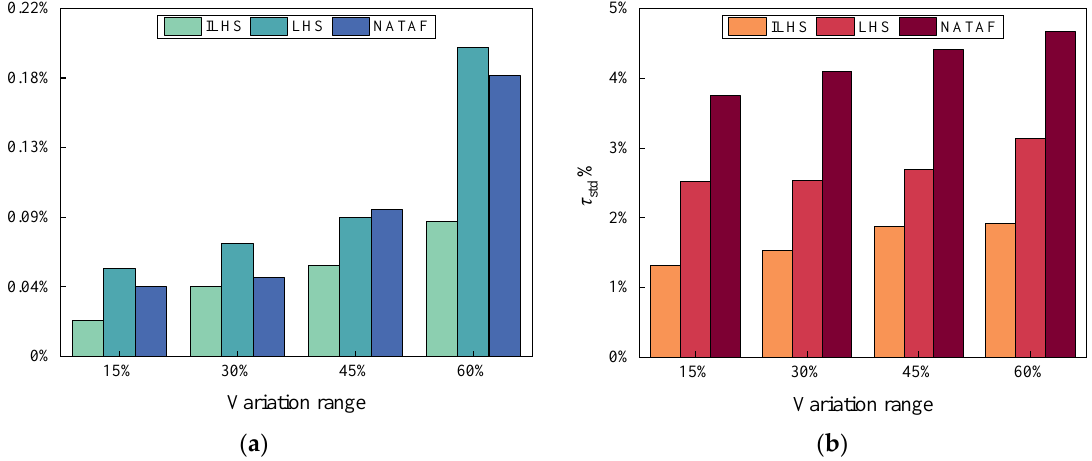
Figure 11. Comparison of ( a ) the mean error and ( b ) the standard deviation error of the AC bus voltage magnitudes under different fluctuation ranges of each load.